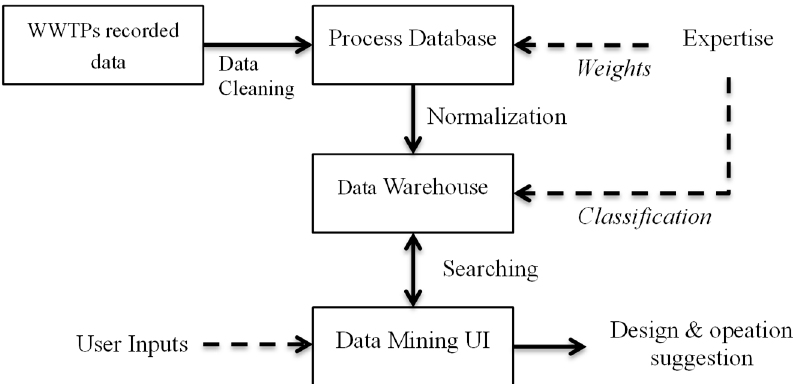
Figure 1. The scheme of a data mining system for optimizing the process design and operation in wastewater treatment plants. The solid lines represent automatic procedure and dash lines are involved with expert knowledge. WWTPs—wastewater treatment plants; UI—user interface.